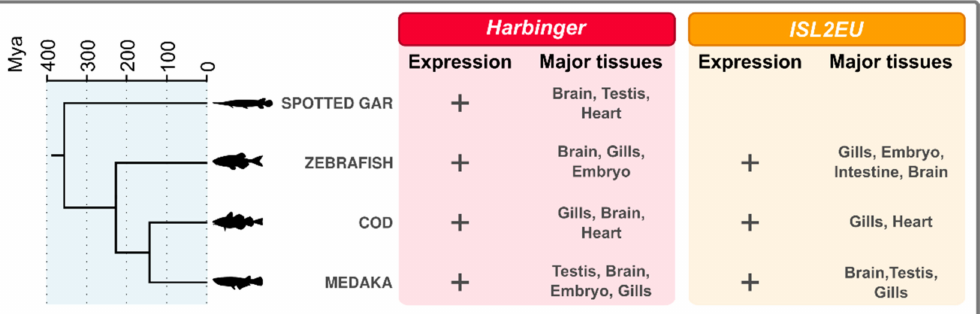
Figure 6. Expression analysis of Harbinger and ISL2EU transposons in spotted gar, zebrafish, cod and medaka using the PhyloFish database [37]. Expression identified in PhyloFish database is indicated with +. Absence of “+” indicates that the element was not detected in the genome. For each species, the organs where the TEs are mainly expressed are indicated.